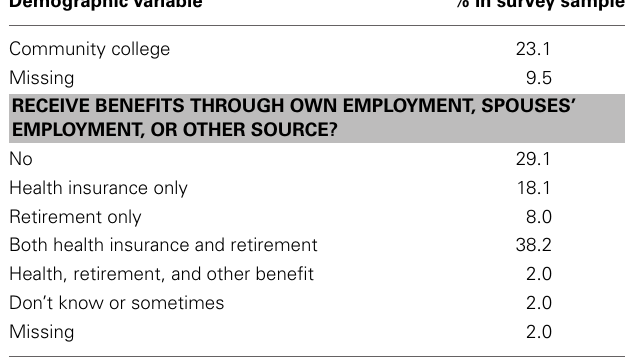
Table 1 | Participants’ demographic characteristics for Part 1 of the